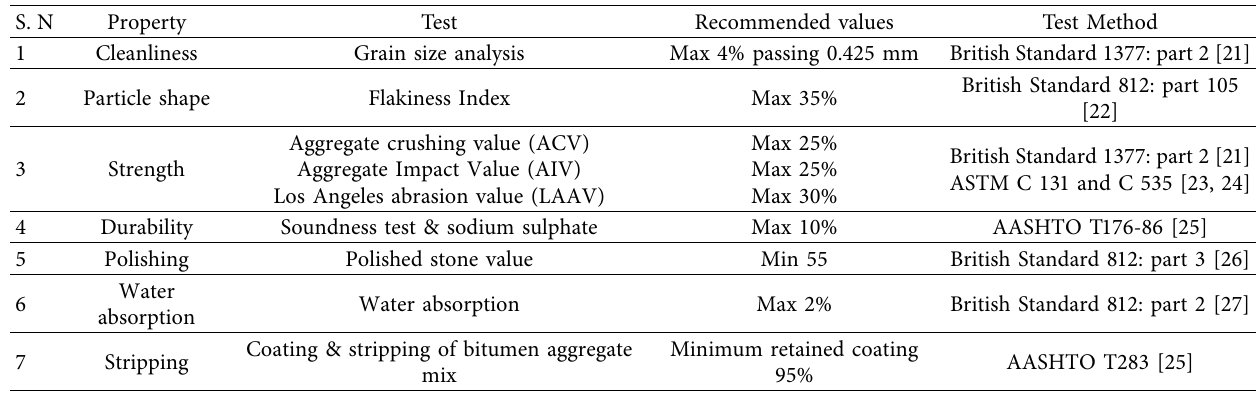
Table 2: Physical properties of aggregates.